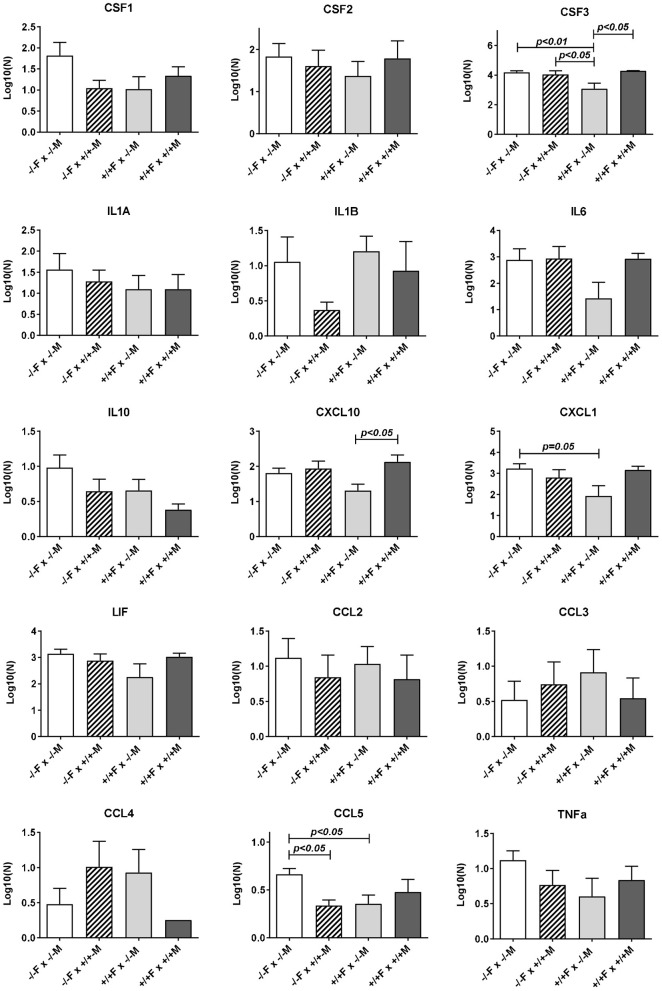
Luminex multiplex analysis of individual cytokines and chemokines present in uterine lavage fluid derived from different mating combinations utilizing Rln+/+ and Rln−/− male and female mice, as indicated. Data were log transformed prior to analysis, and are given as mean ± SEM. p-values indicating effect of treatment group on cytokine content are shown.